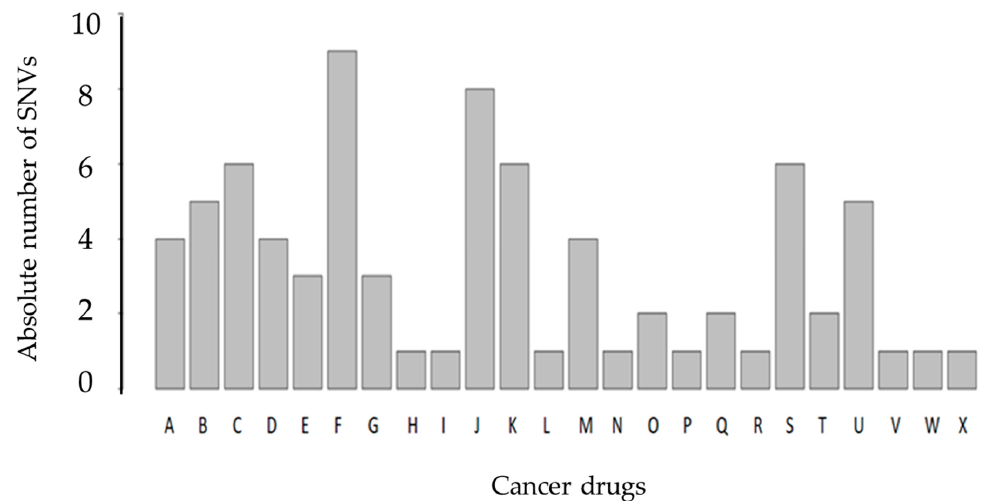
Figure 6. Bar plot of SNVs associated with known cancer drugs in the PharmGKB database. The PharmGKB database gathers all currently reported variant–drug interactions by at least two different scientific publications. The x-axis illustrates the cancer drugs, anthracyclines ( A ), capecitabine ( B ), carboplatin ( C ), cisplatin ( D ), cyclophosphamide ( E ), docetaxel ( F ), doxorubicin ( G ), doxorubicinol ( H ), exemestane( I ),fluorouracil( J ),gemcitabine( K ),imatinib( L ),irinotecan( M ),letrozole( N ),leucovorin( O ), lonafarnib ( P ), methotrexate ( Q ), oxaliplatin ( R ), paclitaxel ( S ), platin compounds ( T ), thalidomide ( U ), tipiracil HCL ( V ), trastuzumab ( W ), and trifluridine ( X ). The y-axis is the number of SNVs